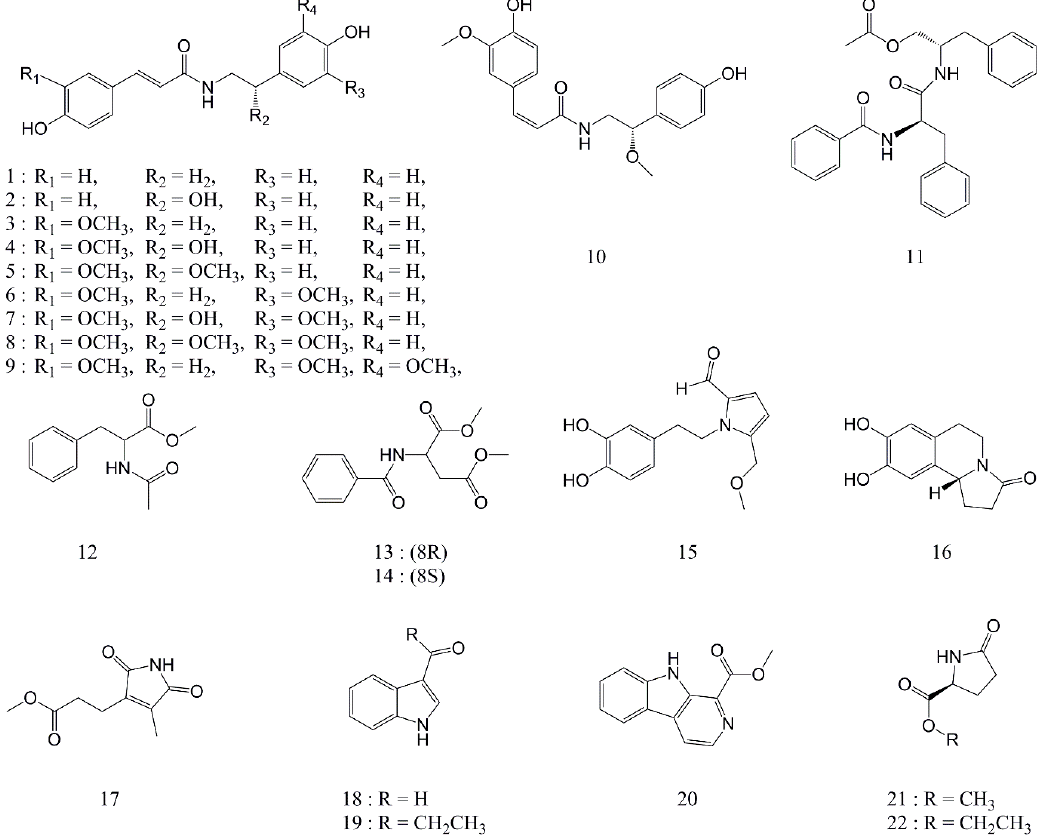
Figure 1. Chemical structures of the isolated compounds ( 1 – 22 ).